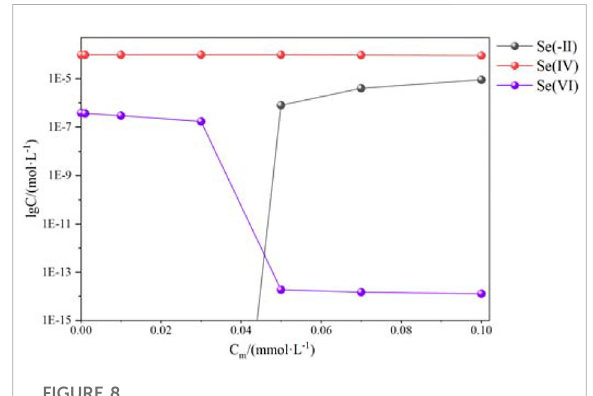
FIGURE 8 Log C of Se(- Ⅱ ), Se( Ⅳ ), and Se( Ⅳ ) as a function of the magnetite concentration.